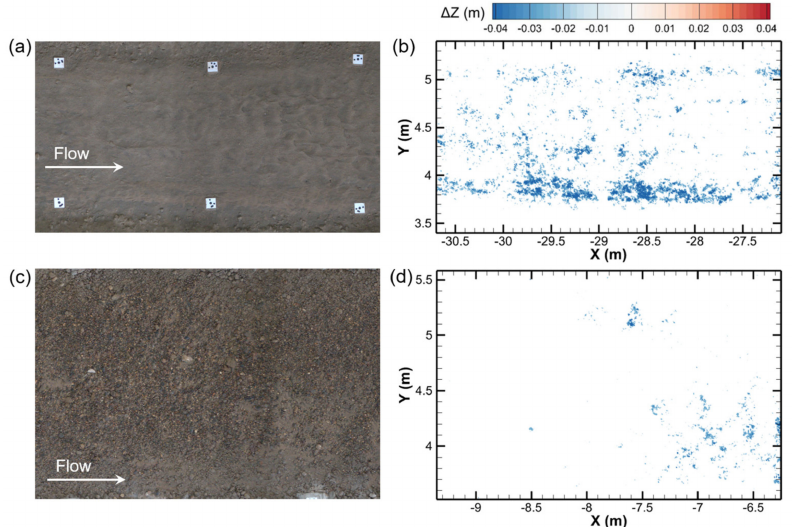
Figure A4. Locations of the points with distinct elevation error < − 0.02 m in the corrected models using the bank GCPs: ( a , b ) present the digital orthophotomosaic (DOM) of the dry bed surface and the spatial distribution of the distinct elevation errors at Q = 120 L/s in MR1, respectively; ( c , d ) are the DOMs of the dry bed surface and the spatial distribution of the distinct elevation errors at Q = 120 L/s in MR2, respectively.